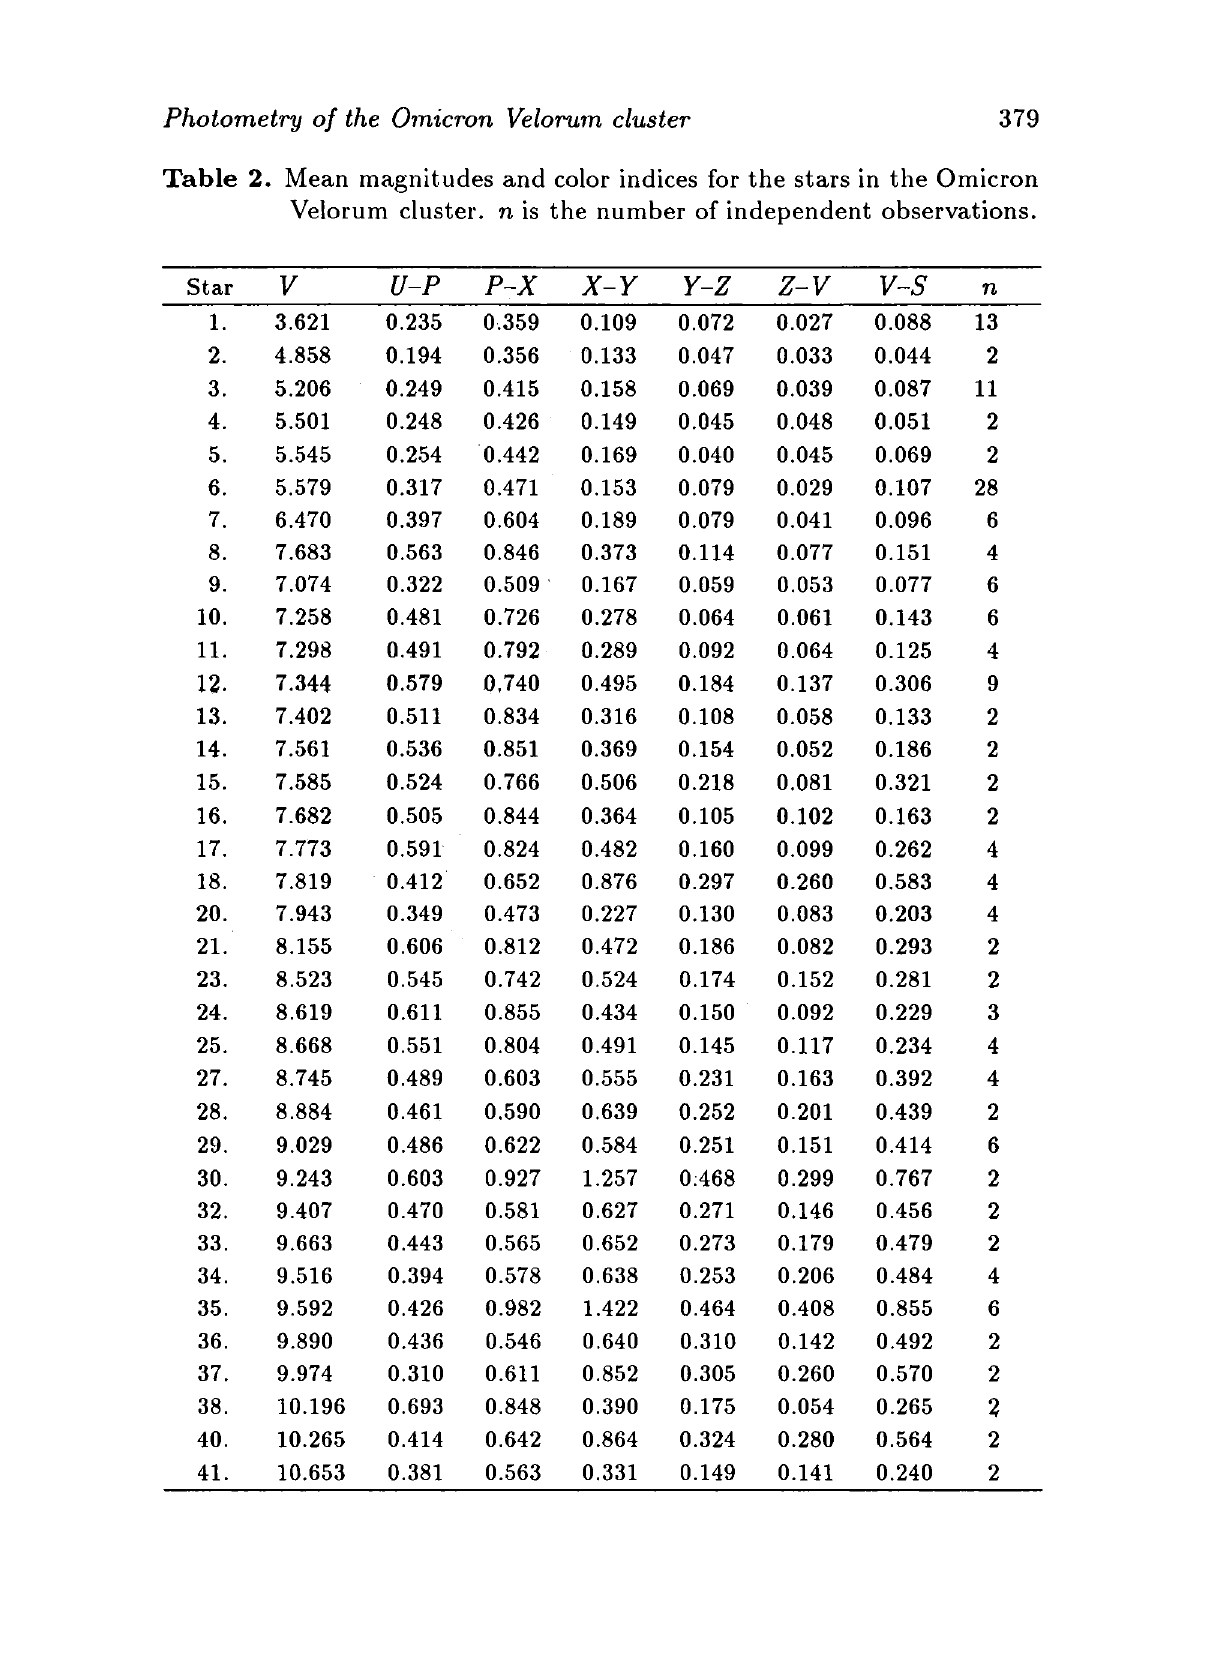
Table 2. Mean magnitudes and color indices for the stars in the Omicron Velorum cluster, n is the number of independent